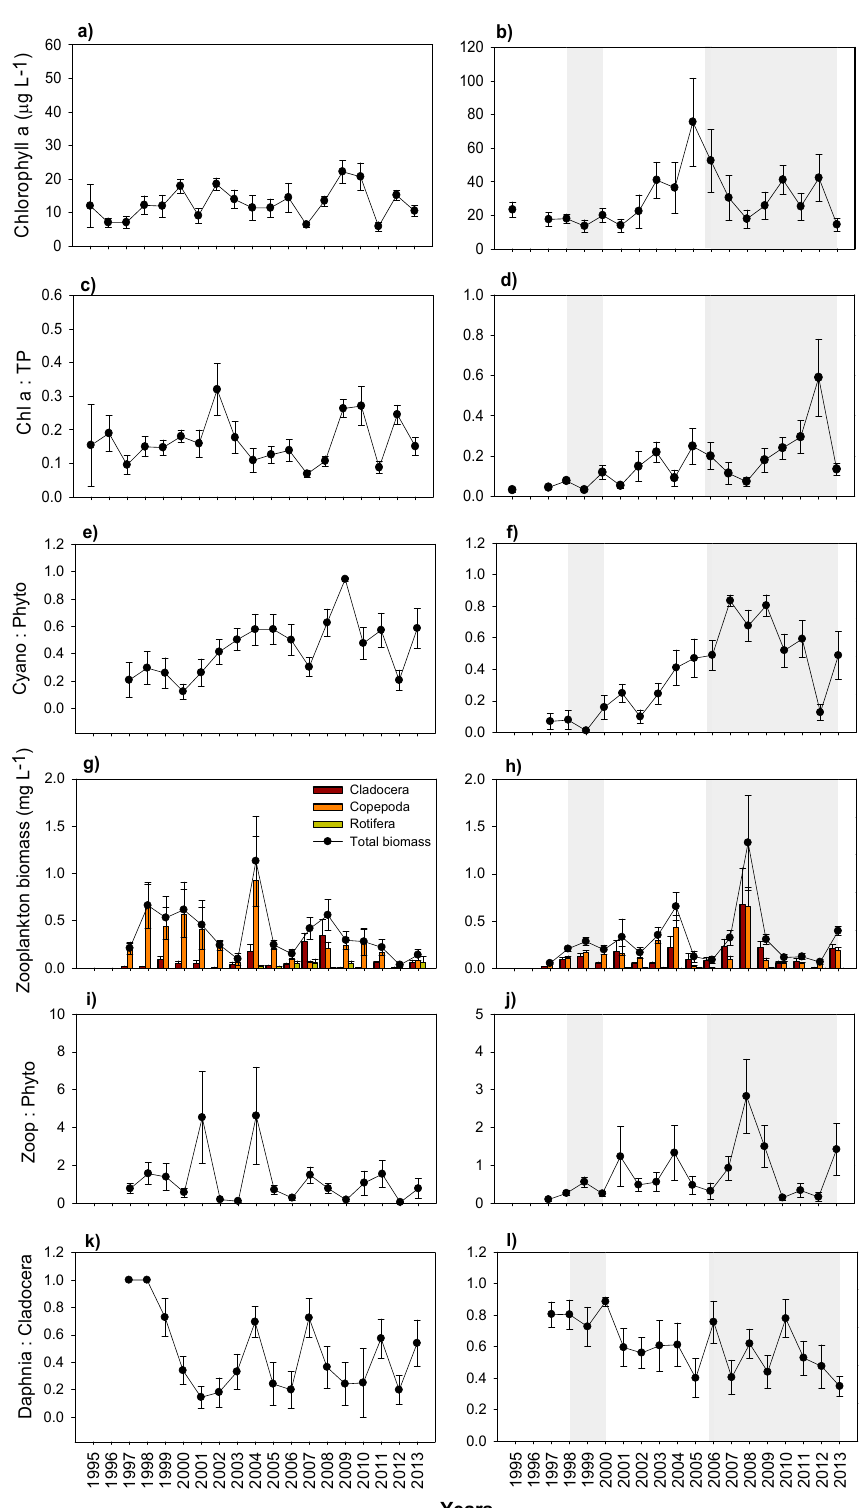
Figure 9. Changes in yearly mean (with ± SE); ( a , b ) Chlorophyll a ; ( c , d ) Chla:TP (Phytoplankton yield); ( e , f ) cyanobacteria to total phytoplankton ratio; ( g , h ) zooplankton biomass; ( i , j ) zooplankton to phytoplankton ratio; ( k , l ) Daphnia to Cladocera ratio, in Lake Mogan (left panels) and in Lake Eymir (right panels) (shaded periods indicate the first and second biomanipulation). Note the scale differences on the y ‐ axes.